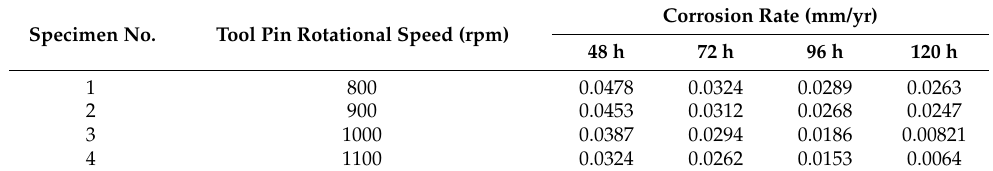
Table 5. Summary of the corrosion test.